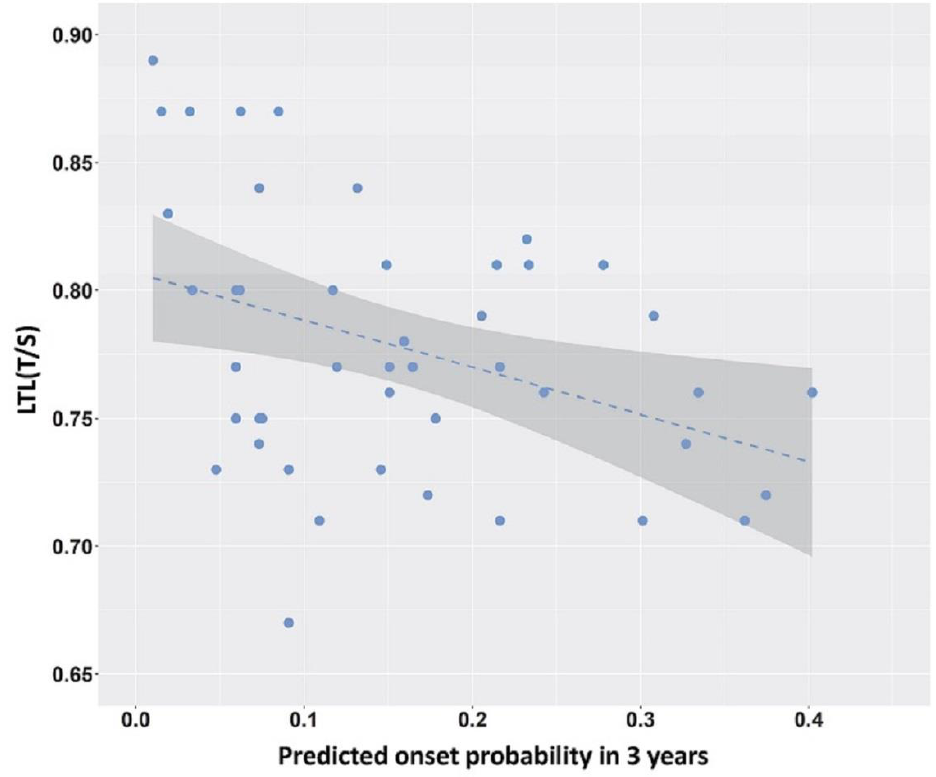
Figure 4. LTL values for pre-HD patients as a function of probability of disease onset in 3 years. The probability of onset was calculated according to Langbehn, 2004 [8]. Linear regression line is shown. Spearman correlation index r = − 0.35, p = 0.016.